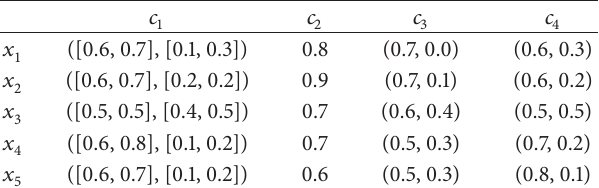
Table 5: Evaluation information at 𝑡 5 time episode.